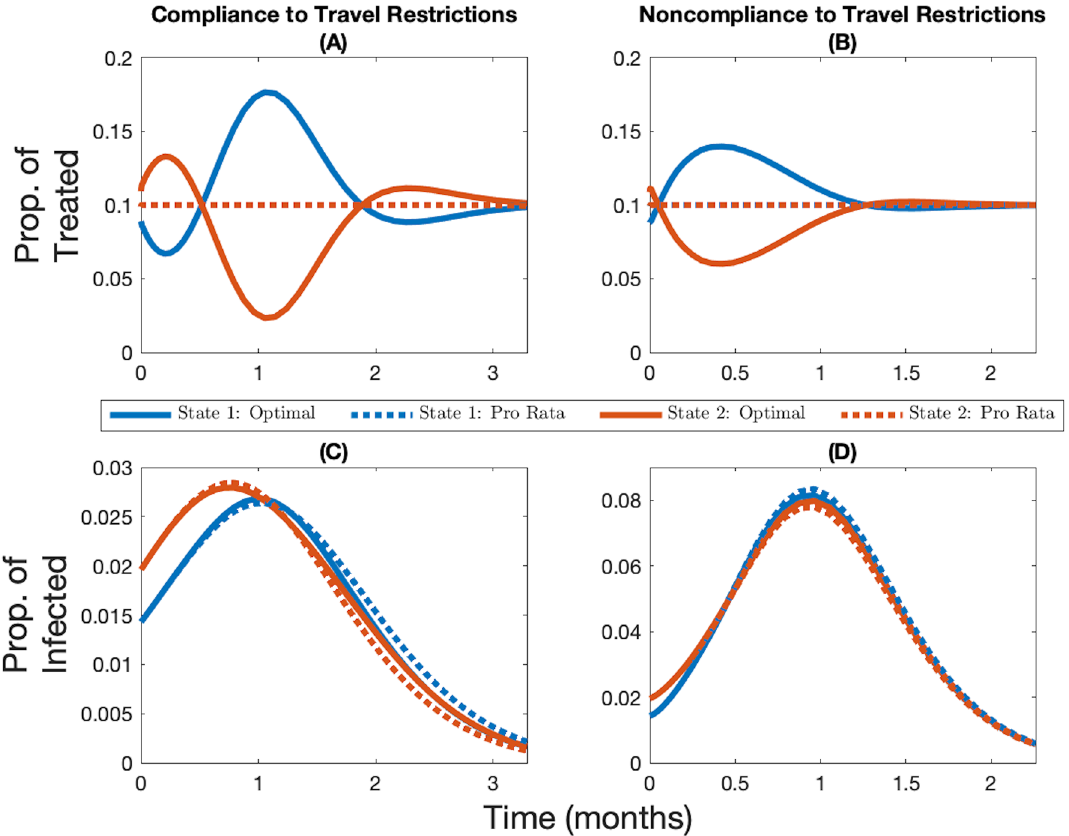
Figure 2. Vaccine allocation with and without compliance to travel restrictions. Change over time in the optimal and pro rata allocations ( A , B ) and the corresponding infection levels ( C , D ) for State 1 (in blue, the initially lowest-burdened state) and State 2 (in red, the initially highest-burdened state) depending on whether there is compliance to travel restrictions ( A , C ) or not ( B , D ) for the case where the vaccine capacity constraint is 10% and immunity is permanent. Note the changing y -axis in panels ( C ) and ( D ) in order to better highlight the infection